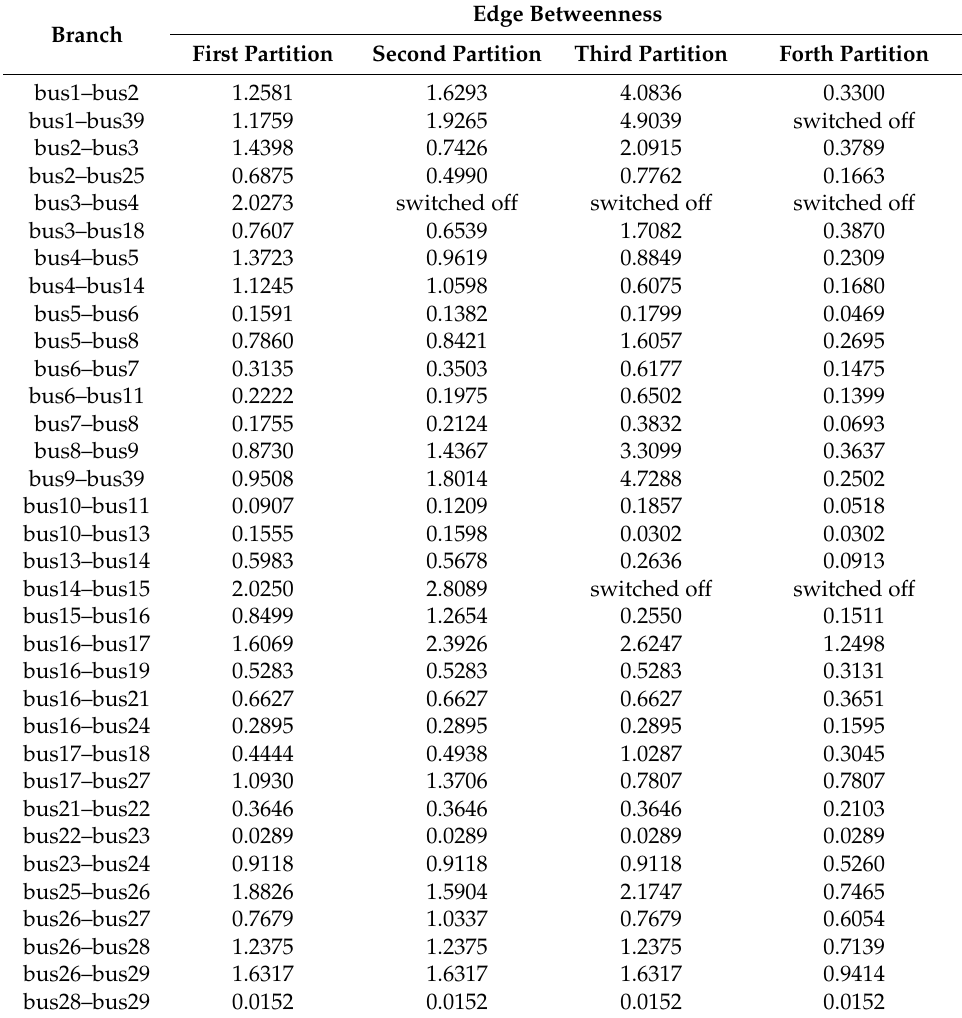
Table 1. Edge Betweenness of Each